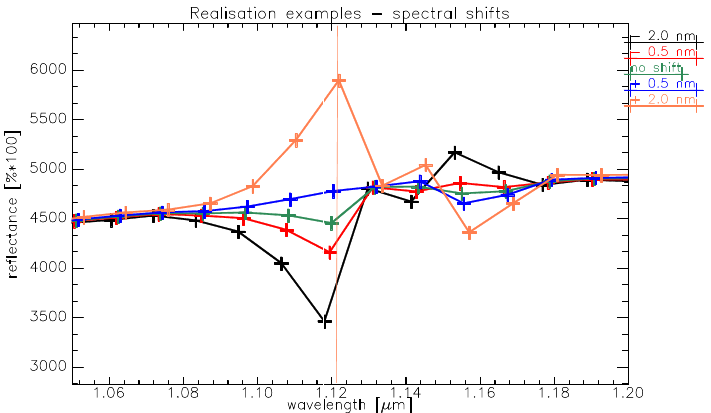
Figure 10. Plot of the reflectance spectra of five realizations, zoom on the red edge region of a ground pixel covered by vegetation.